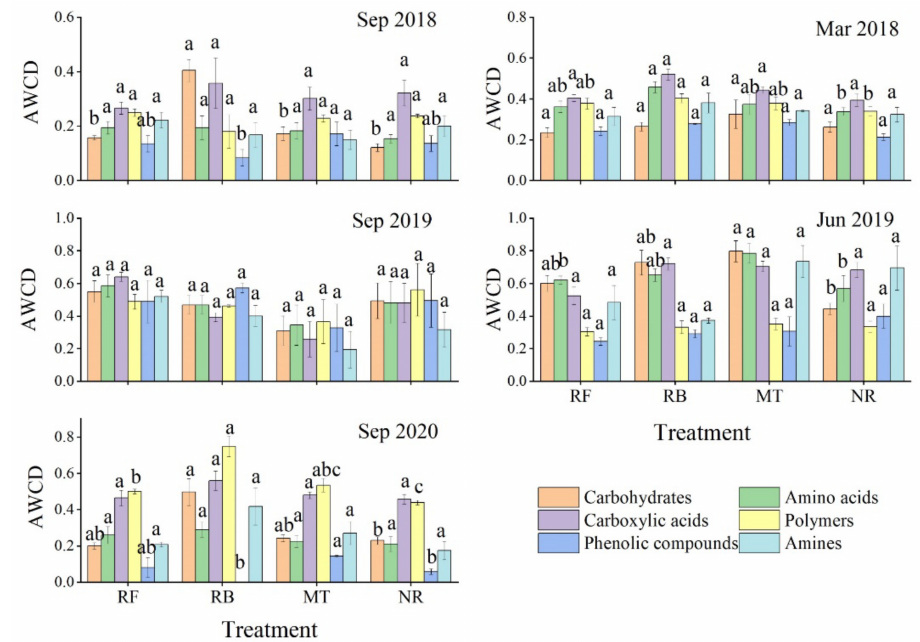
Figure 4. Effects of different harvest residue managements on the AWCD of six carbon sources (carbohydrates, polymers, carboxylic acids, phenolic compounds, amines, and amino acids) at 96 h. Data are means ± standard errors, and different lower-case letters indicate significant differences among residue treatments ( p < 0.05).